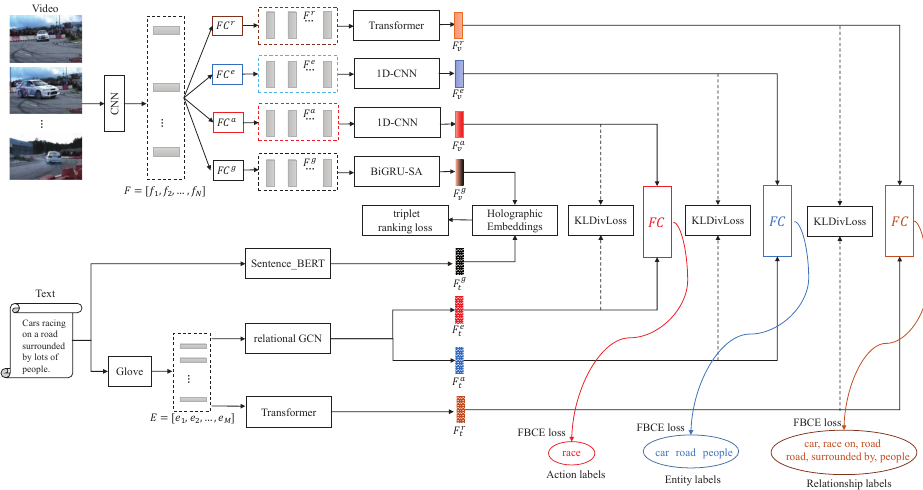
Figure 3. Framework of the proposed multi-level cross-modal semantic alignment network